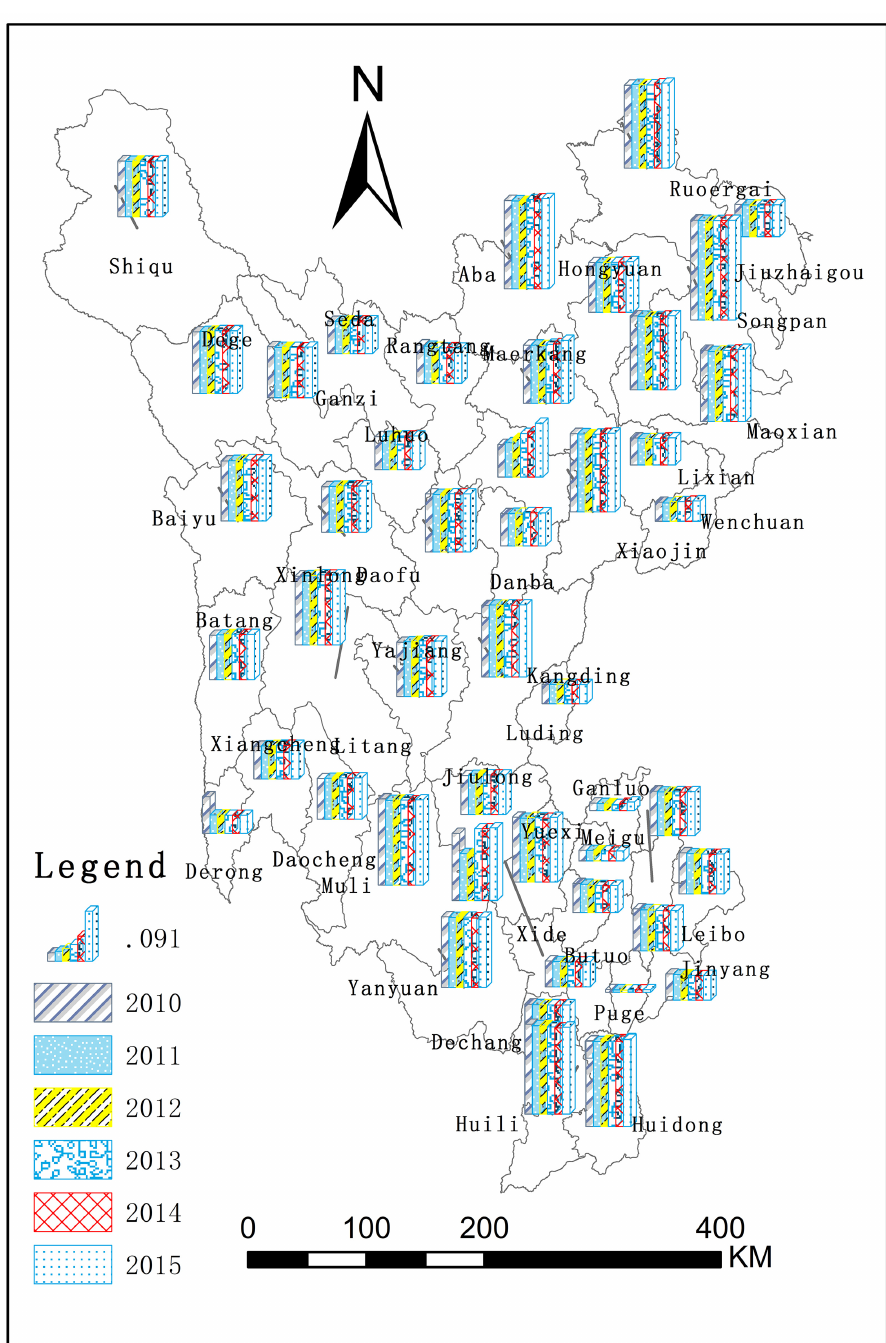
Figure 4. Natural capital